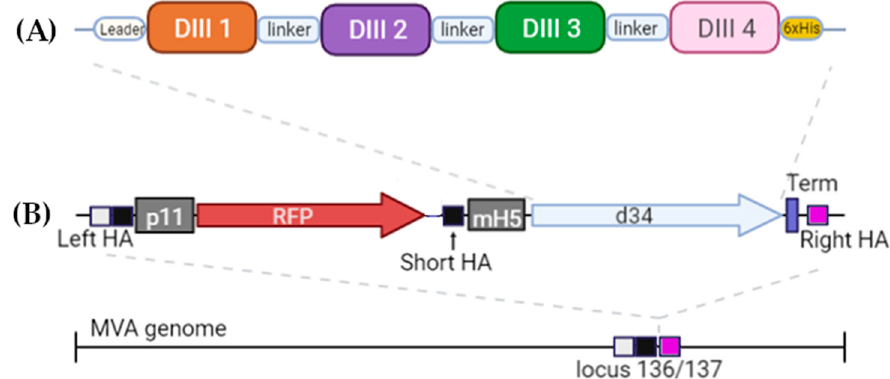
Figure 1. Multiple sequence alignment of the DIII domain amino acid residues of the dengue virus serotypes 1 (aa 578–676, record ID NP_059433), 2 (aa 578–676, record ID NP_056776), 3 (aa 576–674, record ID YP_001621843), and 4 (aa 577–675, record ID NP_073286) used to obtain the d34 antigen sequence. The color shows the similarity in the sequence.